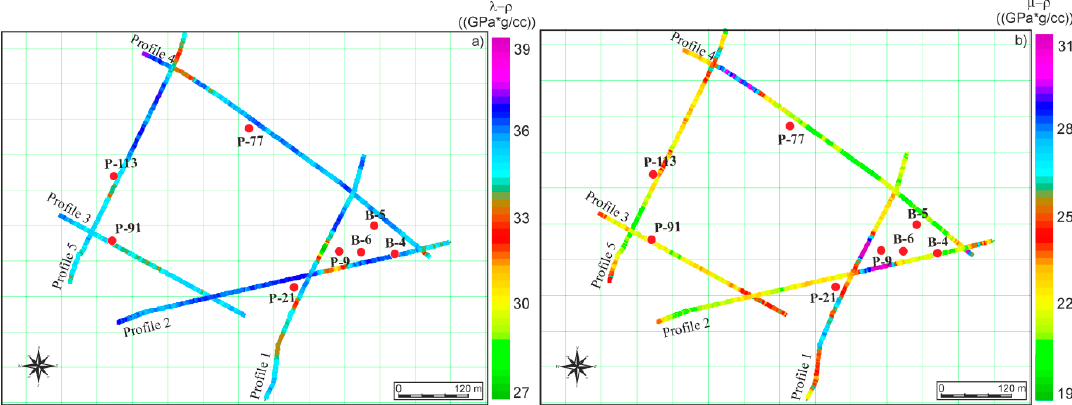
Figure 14. A map of root mean square values of ( a ) λ - ρ and ( b ) μ - ρ , along all five seismic profiles derived for the evaporitic formation. The average λ - ρ value is 35–37 GPa ∙ g/cc, which implies homogenous sulfur distribution within the reservoir interval. A wide range of μ - ρ attribute values (20–30 GPa ∙ g/cc) suggests lithofacial variability of the study area.